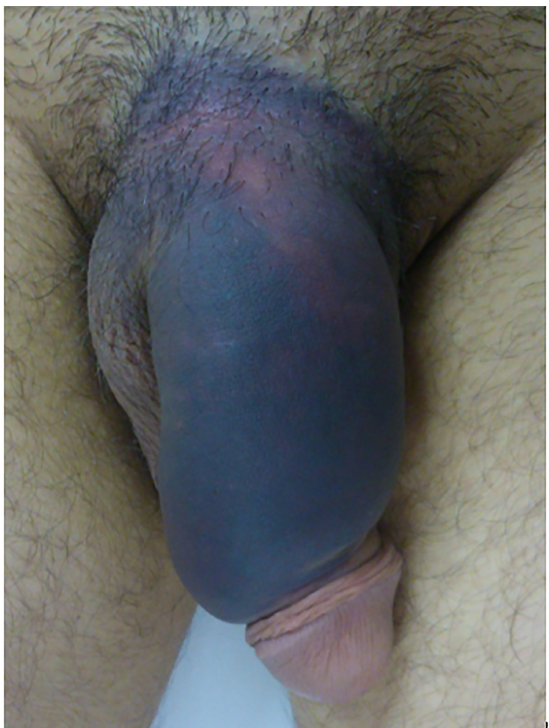
Figure 2 – Unilateral rupture of right corpus cavernosum, with partial urethral lesion in the only patient with urethral